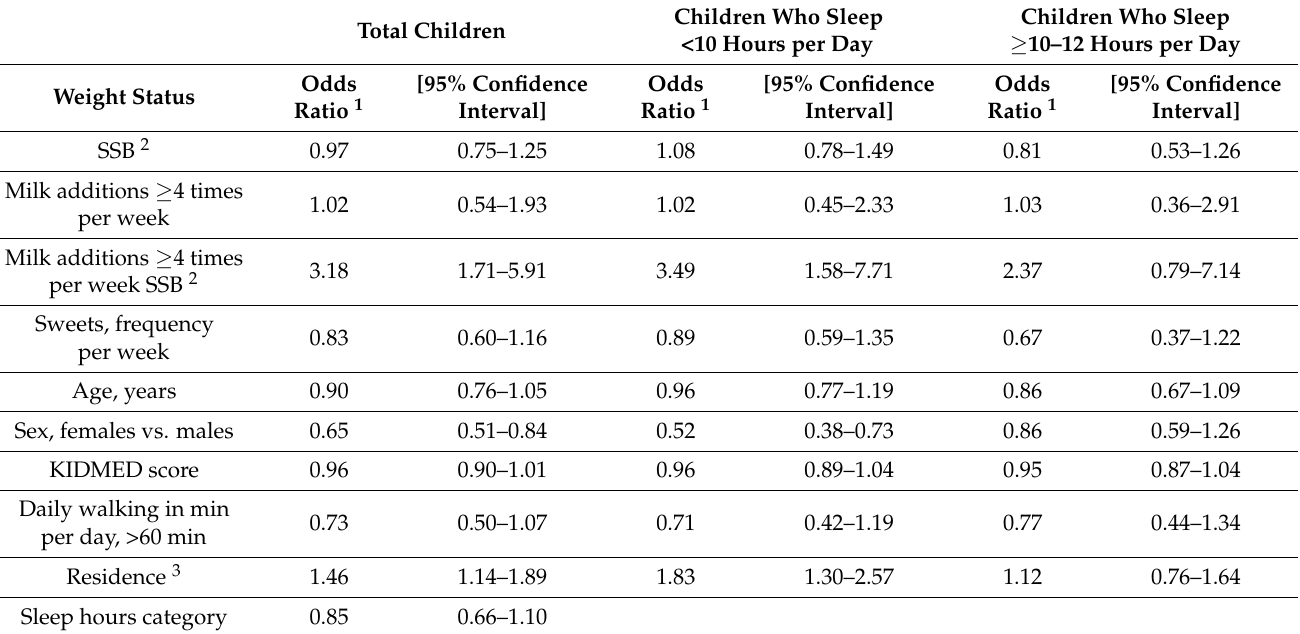
Figure 2. Scatter plot with fitted regression lines of mean BMI levels by the level of daily SSB intake based on the category of total sleep hours. Table 2. Children’s odds of being overweight or obese while accounting for the additive effect of adding sugars to milk and SSB intake using a multivariable logistic regression